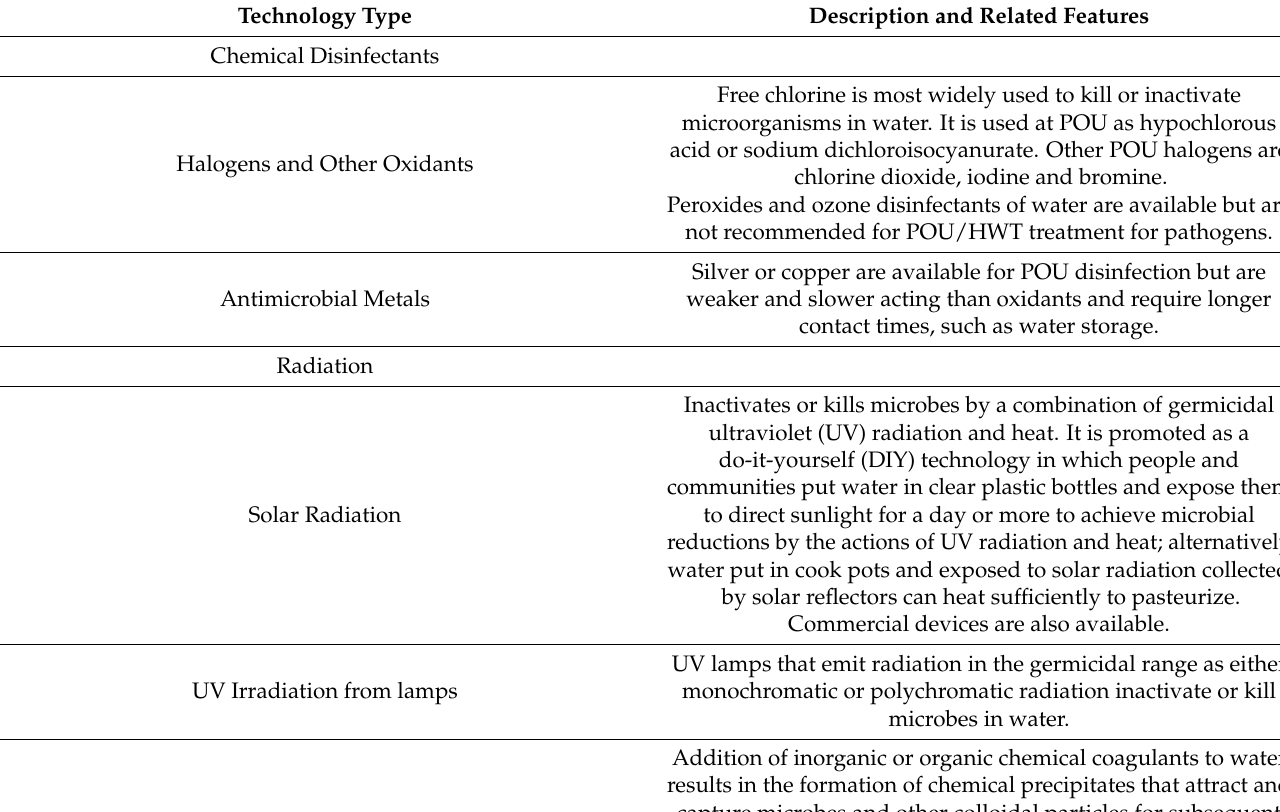
Table 1. Key technologies used for point-of-use (POU)/household water treatment